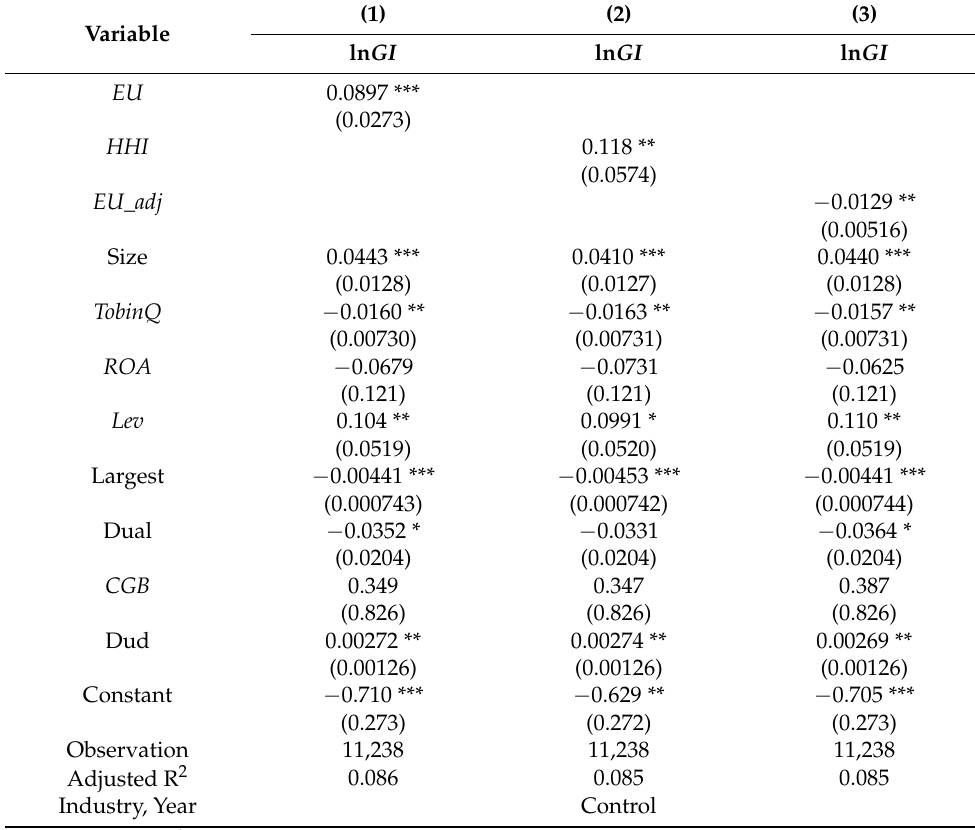
Table 6. Regression Analysis of Environmental Uncertainty and Green Technological Innovation of